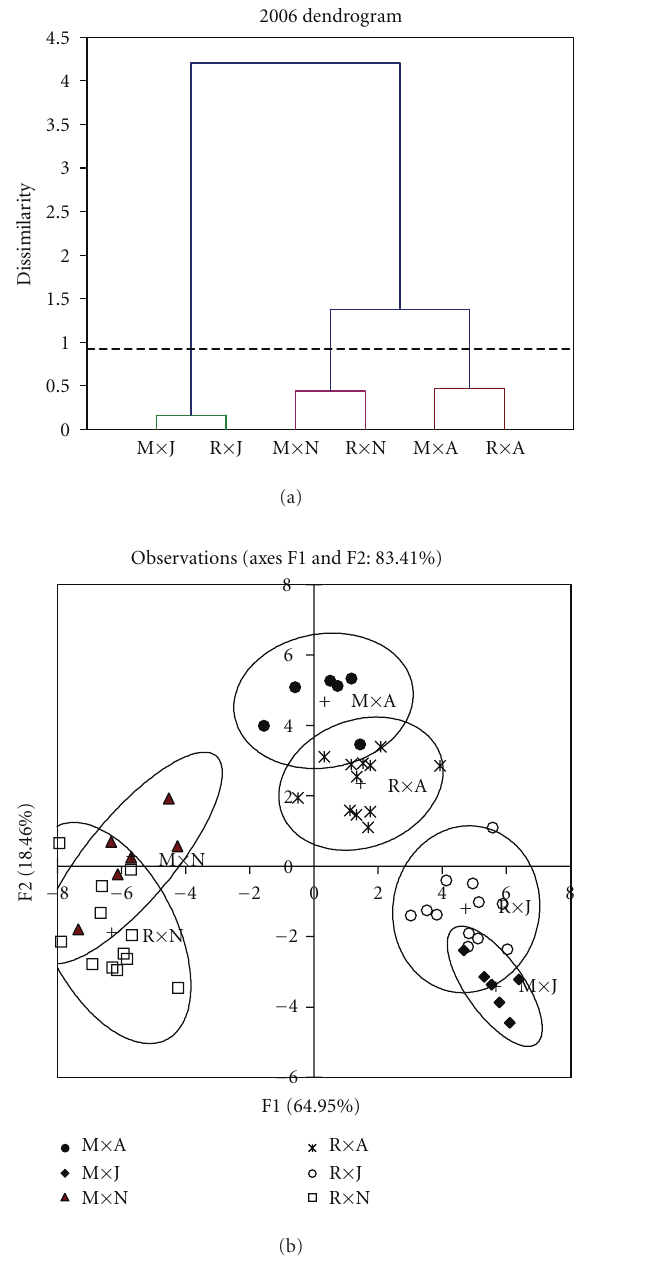
Figure 10: Results of cluster analyses conducted during 2007 on the community level physiological profiles of the soils, as measured using the Biolog EcoPlate method (a) dendrogram and (b) discriminant analysis (DA) (M = monoculture and R = rotation, J = June, A = August, and N =